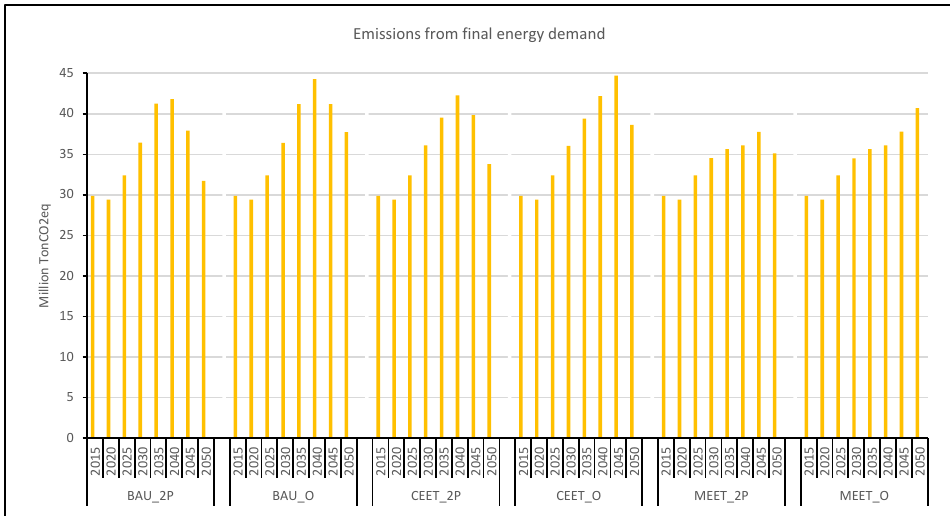
Figure 9. Evolution of GHG emissions per scenario.